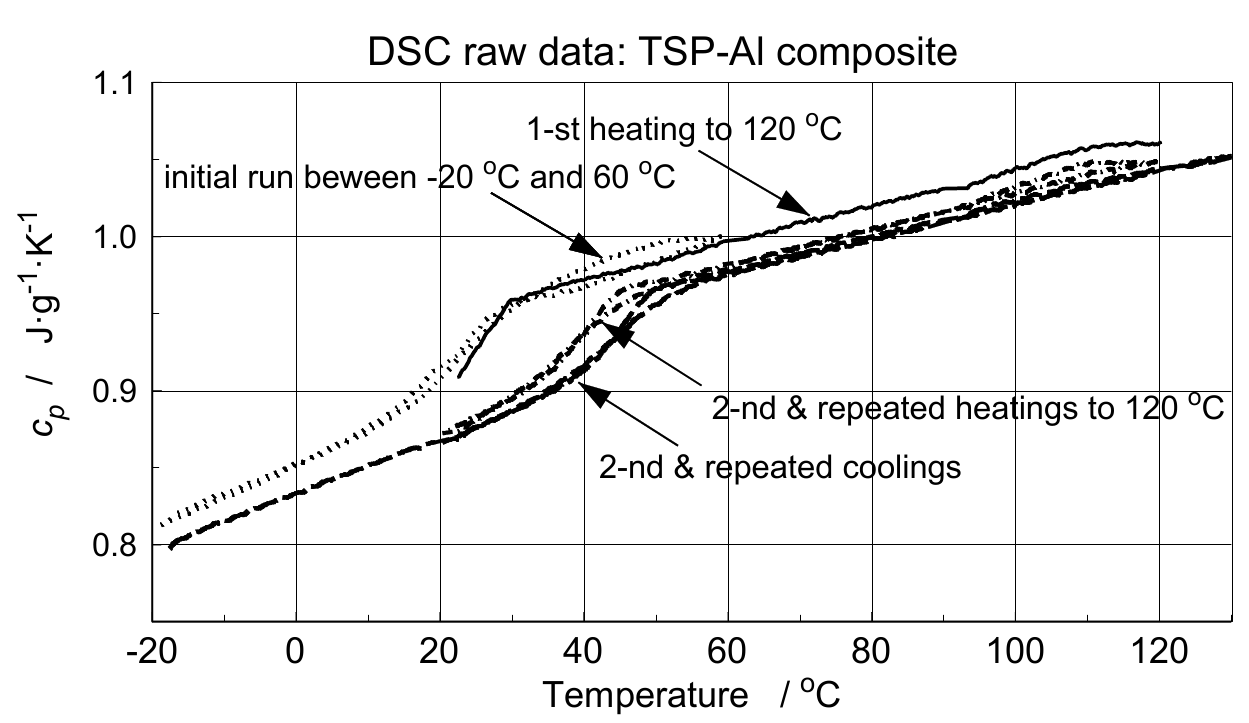
Materials 2021 , 14 , x FOR PEER REVIEW